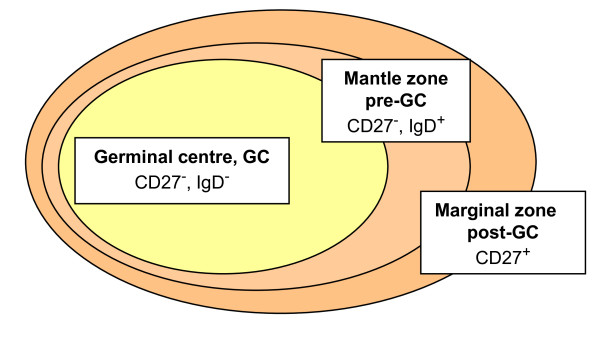
The three major B cell compartments in peripheral lymphoid organs. Presence of the differentiation markers CD27 and IgD in each zone of a B cell follicle is indicated.